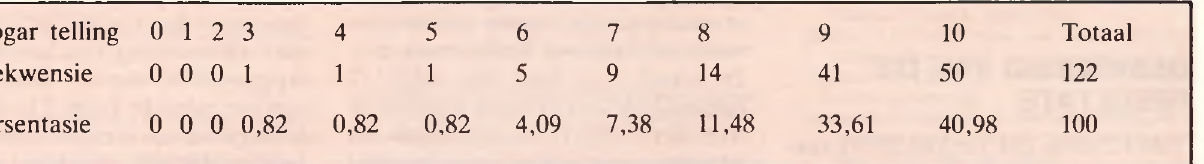
Tabel 2: Frekwensies en persentasies in die verskillende kategorieë van die totale Apgar-tel- ling